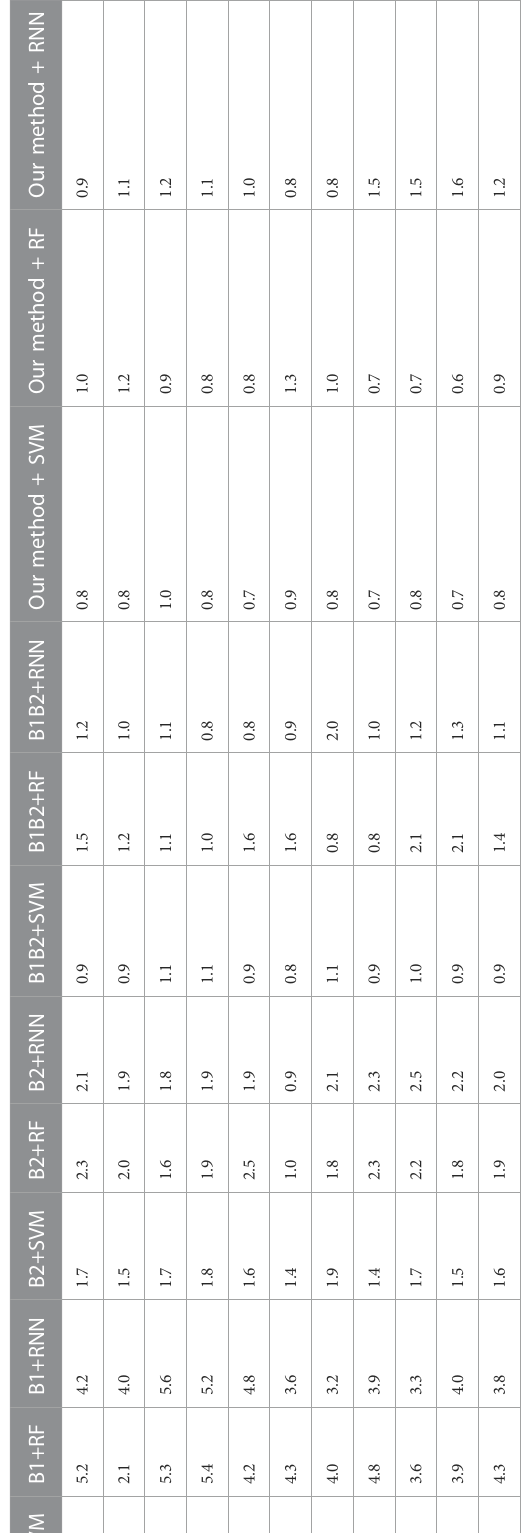
According to Figure 2, a microgrid model that includes wind turbine (10 kW), photovoltaic cell (10 kW), and battery (10 Ah) is built in the MATLAB simulink environment. The fi lter inductances L 1 , L 2 , and L 3 are 3.6e − 3 H; the fi lter capacitors C 1 , C 2 , and C 3 are 200e − 6 F; the electrical loads Load1, Load2, Load3, and Load4 are 10 kVA, 10 kVA, 5 kVA, and 15 kVA, respectively; the line resistance r is 0.175 Ω /km; and the line reactance x is 0.070 Ω / km. Simulate each type of line fault at 10%, 20%, 30%, 40%, 50%, 60%, 70%, 80%, and 90% of the lines between P 1 and P 2 on the microgrid side. The db6 wavelet is selected as the wavelet base, and the simulated A-phase fault voltage is analyzed by three-layer wavelet packets to obtain 2 3 sub signals in different frequency bands, which are reordered from low frequency to high frequency. The wavelet packet signal reconstruction is carried out for each frequency band, and a total of eight wavelet packet reconstruction signals are obtained. The energy entropy of the reconstructed signal of each wavelet packet is calculated, and a set of eigenvectors are constructed from the energy entropy of eight wavelet packets. By the same processing of phase B and phase C voltage signals, a eigenvector containing 24 wavelet packet energy entropy can be obtained X (cid:1) [ x 1 , x 2 , .. . ,x 24 ] T . Taking X (cid:1) [ x ... , x ] T as the input sample of the network, and the 1 ,x 2 , 24 output sample of the network is T (cid:1) [ t 1 , t 2 , . .. , t 4 ] T , t 1 , t 2 and t 3 , respectively, representing the line status of phase A, phase B, and phase C, and t 4 representing whether the fault phase is grounded T A